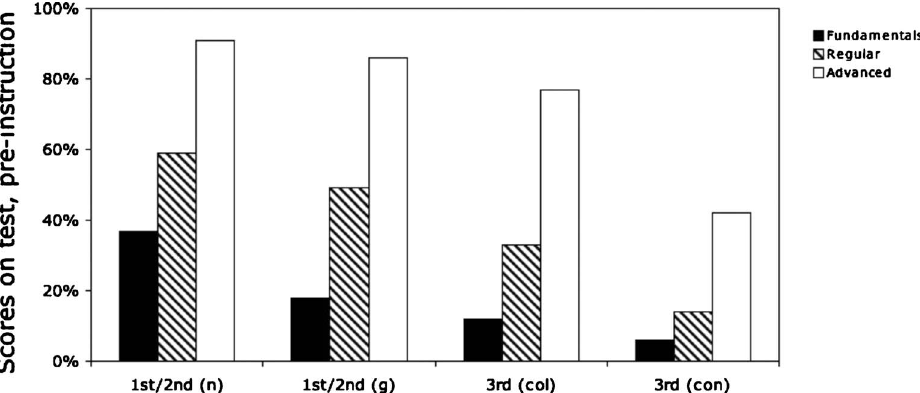
FIG. 1. Preinstruction scores according to the topics covered by the test for the Fundamentals, Regular, and Advanced students